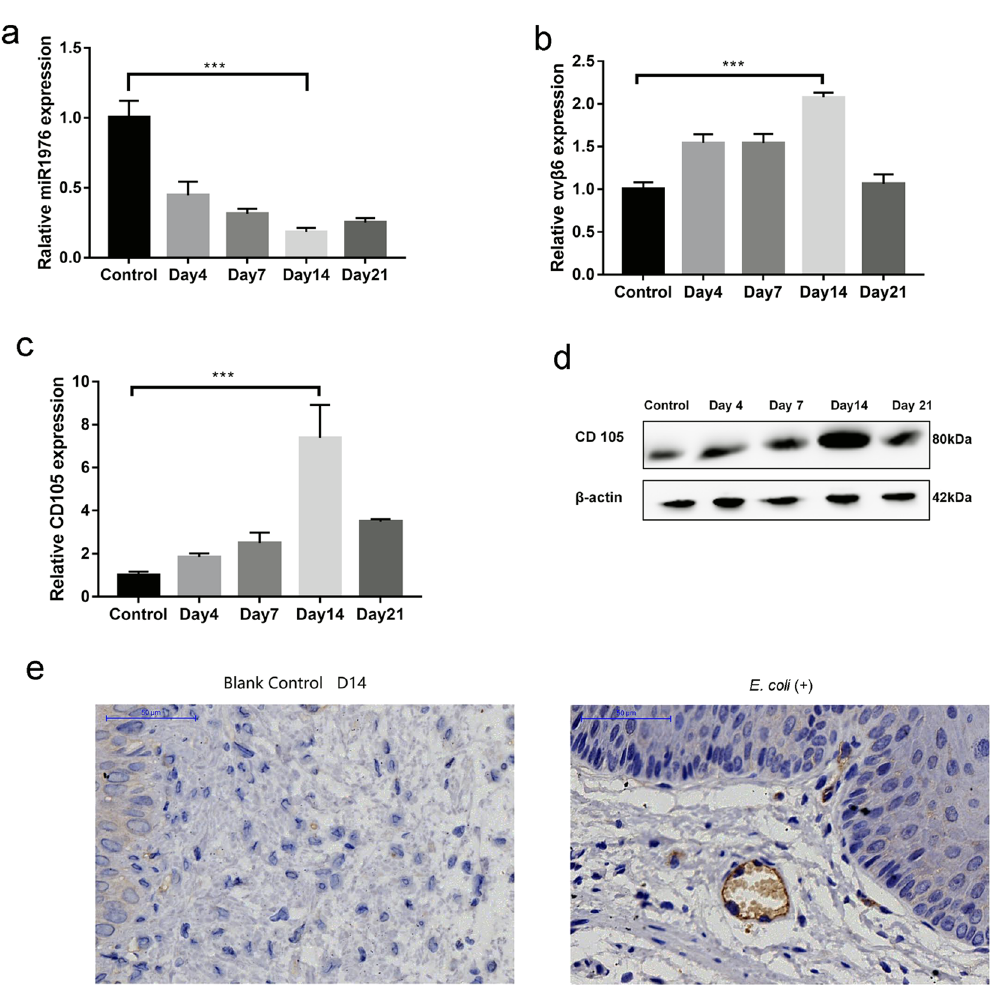
Figure 2. E. coli infection induced abnormal expression of miR1976, CD105 and integrin β 6. ( a ) E. coli infection reduced the expression level of miR1976; ( b ) E. coli infection elevated the mRNA level of integrin α v β 6 in the vaginal tissue of mice; ( c ) CD105 protein expression was increased in the vaginal tissue of mice after E. coli infection, as shown by Western blot analysis; ( d ) The mRNA level of CD105 in the vaginal tissue of mice was increased after E. coli infection; ( e ) E. coli infection increased CD105 protein expression, as shown by immunofluorescence staining. * P < 0.05, ** P < 0.01, compared with the control